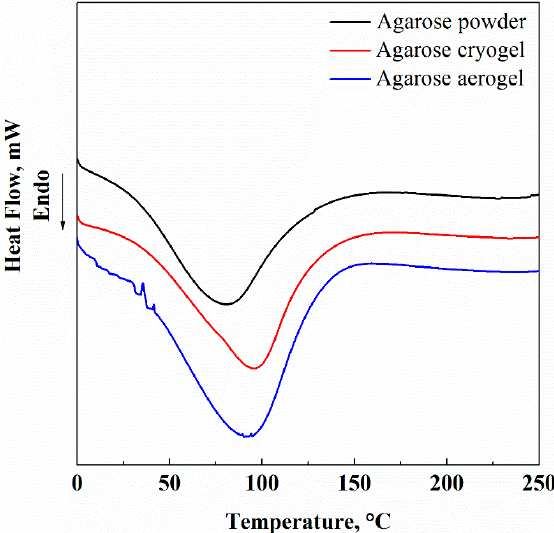
Figure 6. DSC of untreated agarose powder (black line), agarose cryogel (red line), agarose aerogel (blue